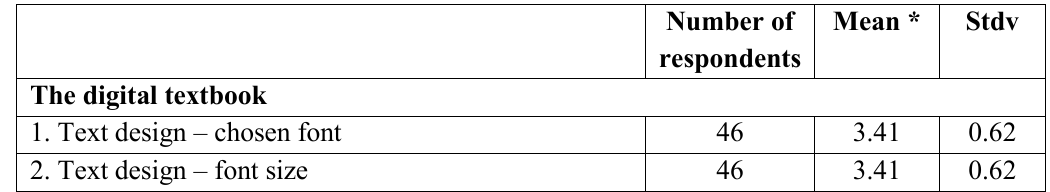
Students’ Attitudes toward the Design of the Digital Textbook and the Video